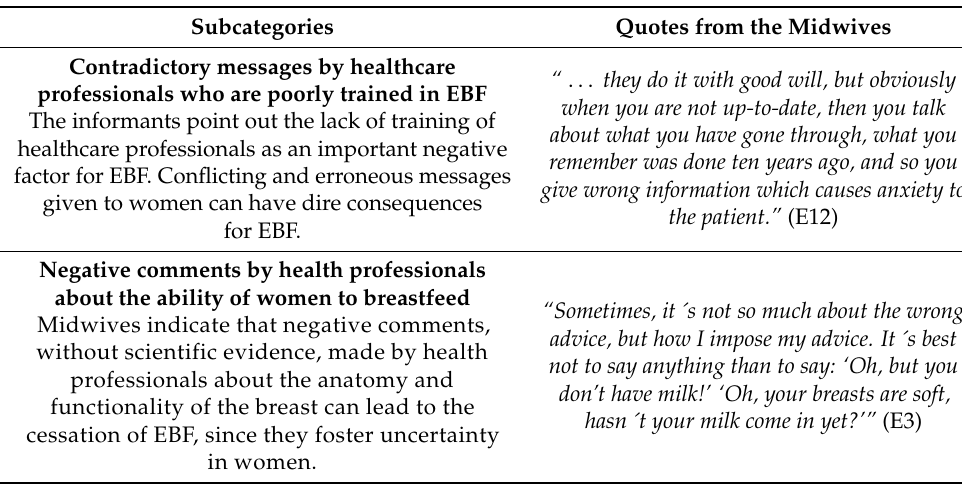
Table 2. Healthcare attention by Primary Care doctors and nurses that hinder EBF. Subcategories Quotes from the Midwives Contradictory messages by healthcare professionals who are poorly trained in EBF The informants point out the lack of training